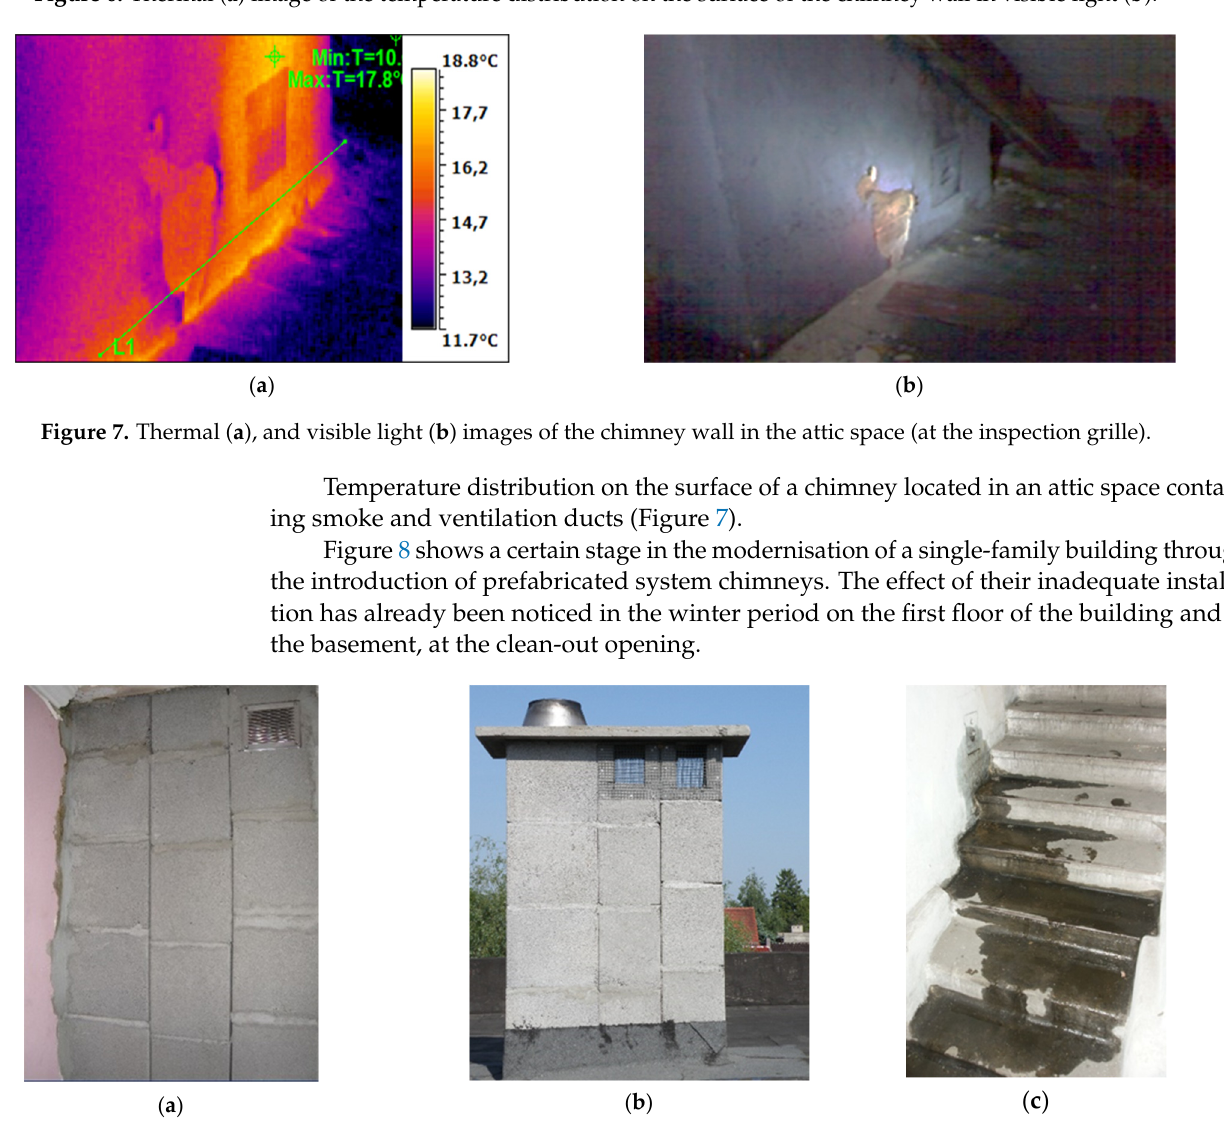
basement through the clean-out opening.